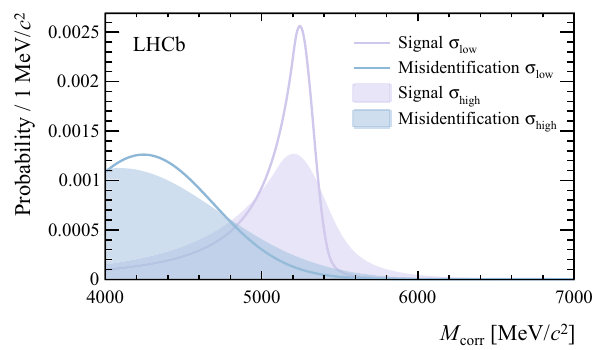
Fig. 3 Template distributions for signal and misidentified background shapes for high and low fractional corrected mass uncertainty. A low uncertainty on the corrected mass corresponds to data with better mass resolution. The shape of the misidentification template is obtained from a control sample while the signal template is obtained from simulation. A systematic uncertainty on the signal shape due to the choice of the signal model is not shown, as it is too small to be visible